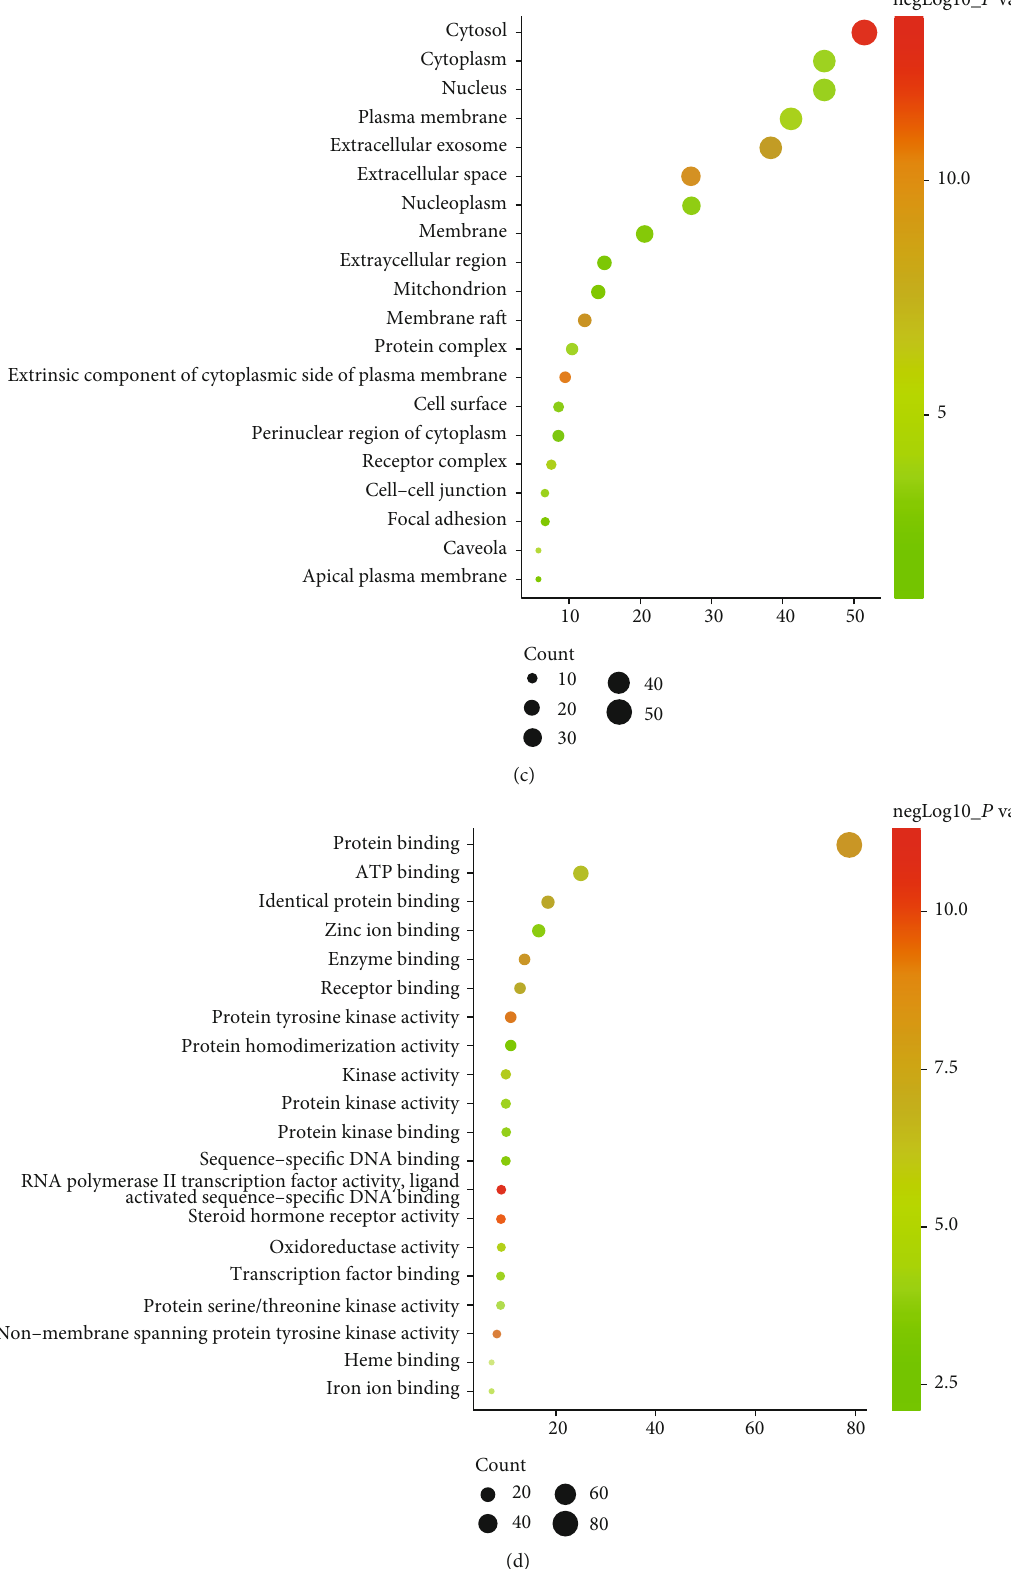
Figure 4: KEGG pathways and GO analyses. (a) KEGG pathway enrichment; (b) biological press (BP); (c) cellular component (c); (d) molecular function